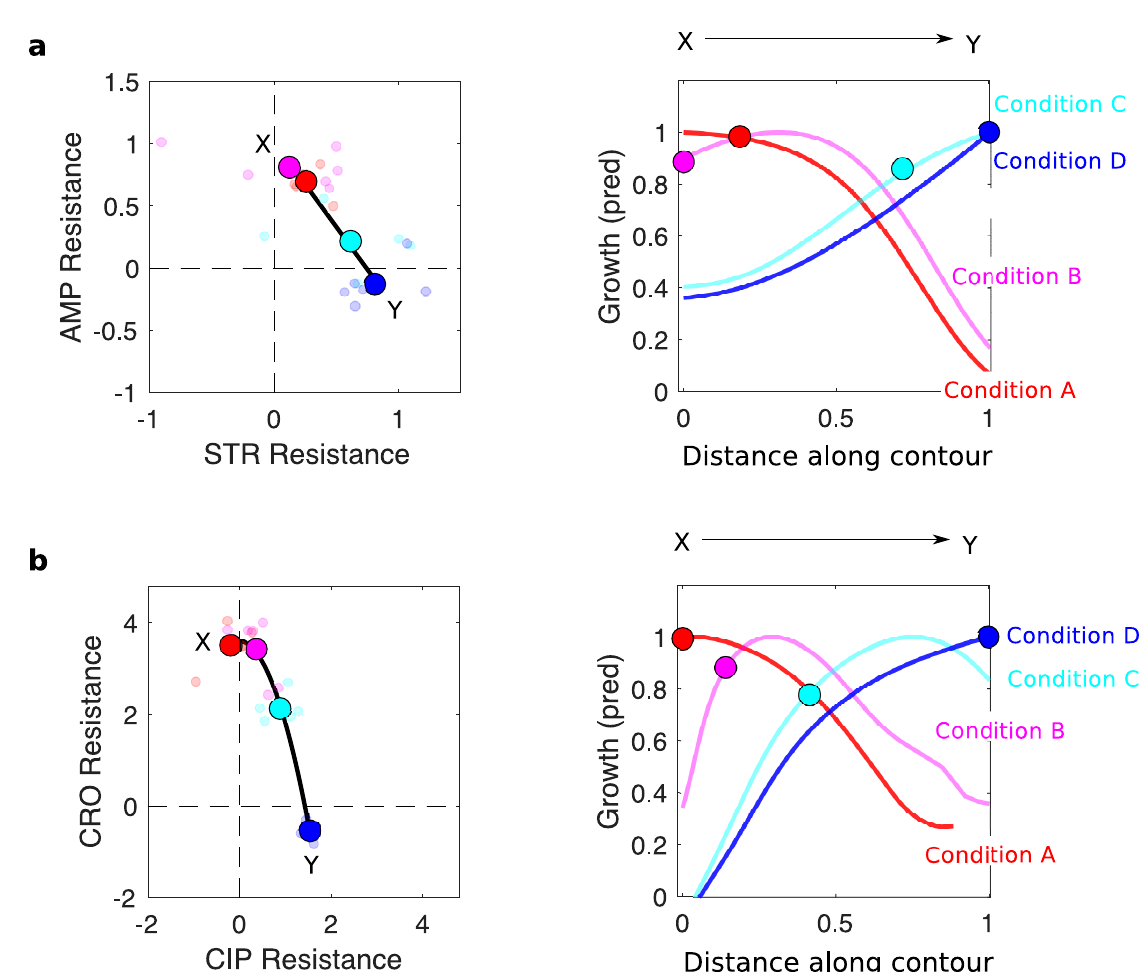
Fig 6. Resistance profiles observed in different AMP-STR and CRO-CIP dosage combinations are (nearly) growth-optimized along the contour separating profiles selected by component drugs. a: AMP-STR, b. CRO-CIP. Left panels: resistance profiles for individual populations (small circles) and the mean across populations (large filled circles) for each selecting condition. Color scheme is the same as in previous figures (i.e. red is condition A, magenta condition B, cyan condition C, and blue condition D). Solid black lines are linear (a) or quadratic (b) fits to the averaged resistance profiles, which create smooth contours in the 2-d resistance space. Right panels: each curve shows the predicted growth for populations with a range of resistance profiles (falling on the contours, left panels) grown at one specific selecting condition (A, red; B, magenta; C, cyan; D, blue). The horizontal axis corresponds to position along the contours (left panels). Filled circles correspond to the locations of experimentally observed (mean) resistance